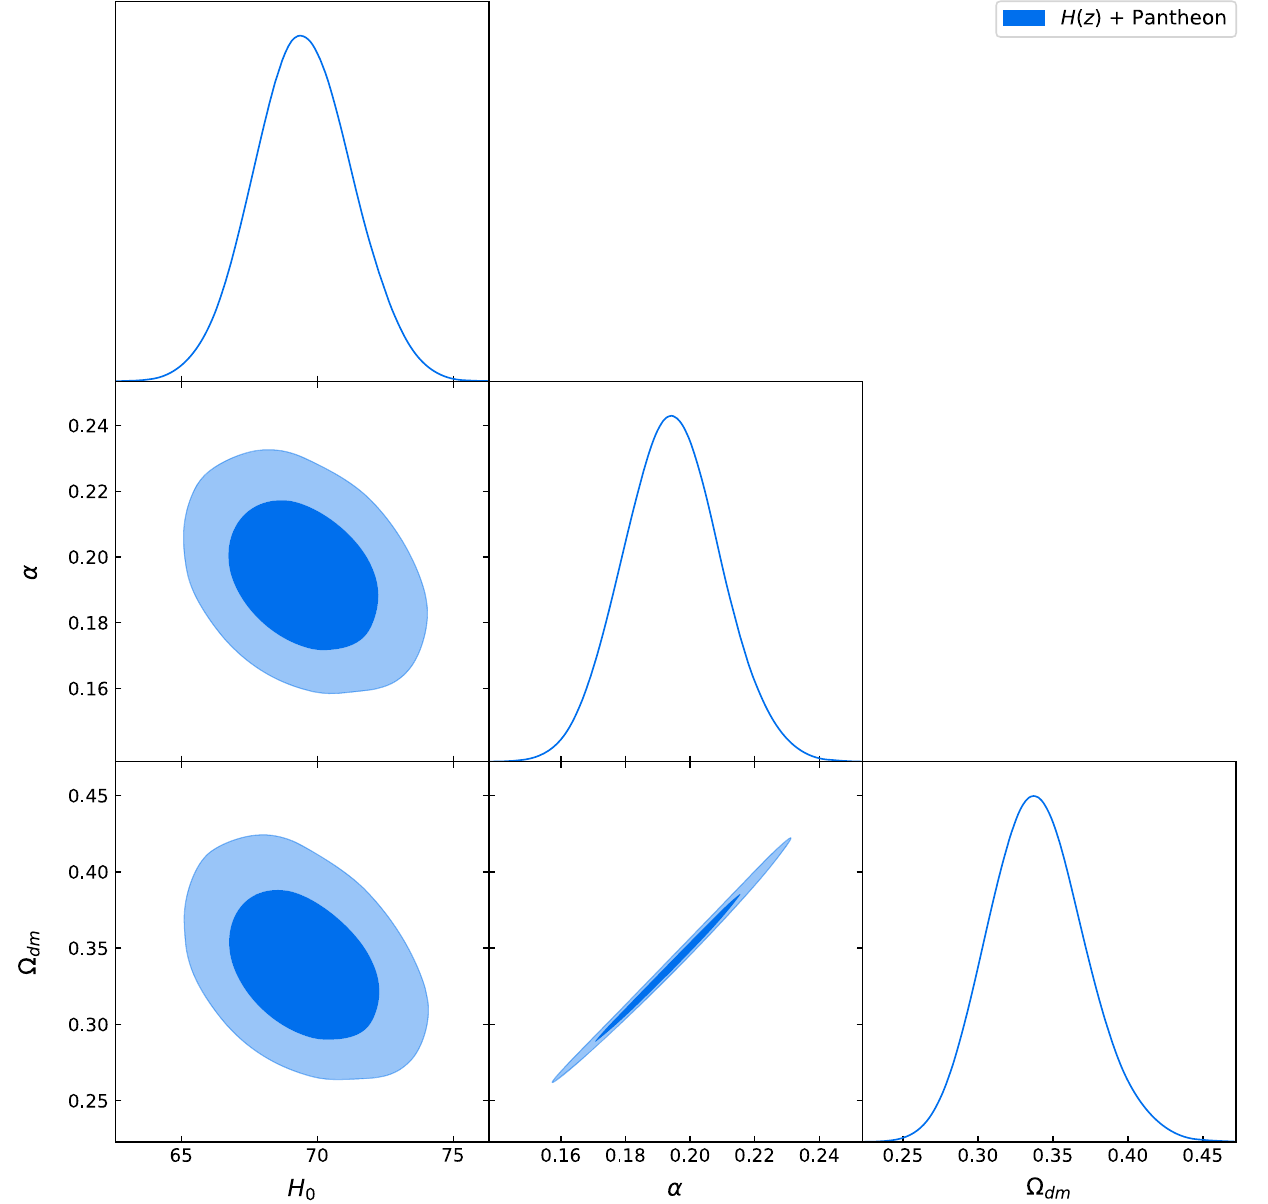
Fig. 4 Joint analysis using SNe Ia – Pantheon and 31 H ( z ) data – Cosmic Chronometers, for the constraints of the main parameters, H 0 and α , and also for the derived parameter (cid:7) dm , for Case